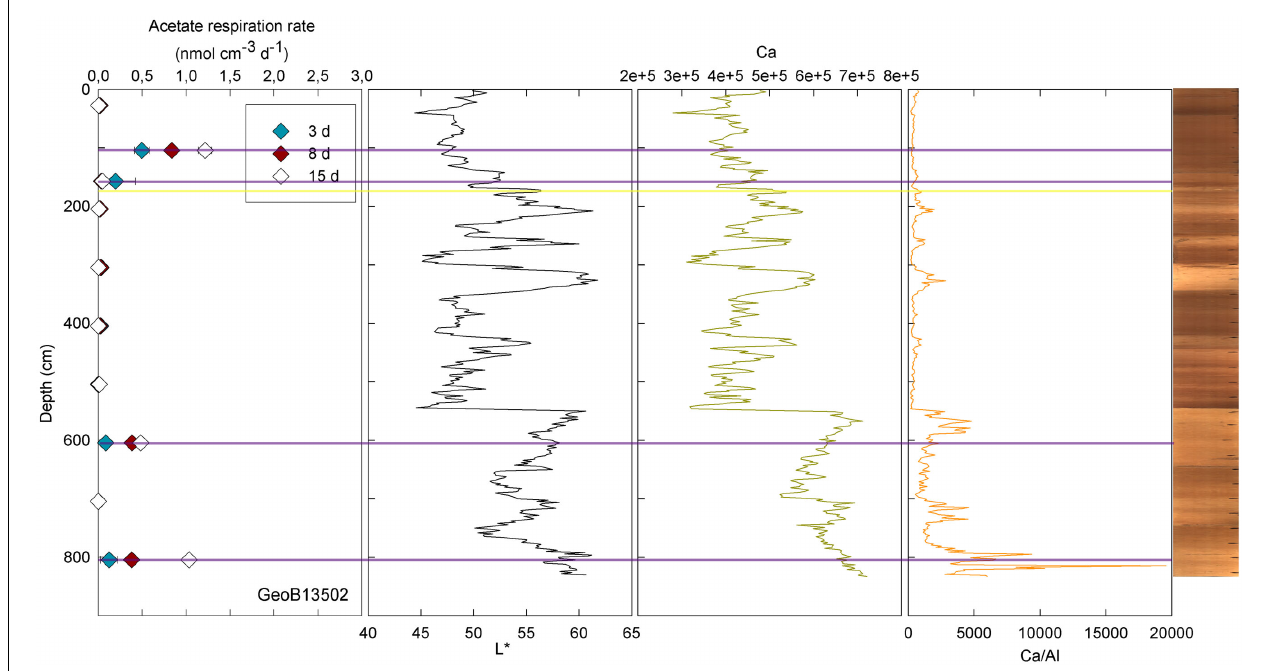
FIGURE 6 | GeoB 13502 linked activities (at 27.5, 104.5, 157, 204.5, 304.5, 404.5, 504.5, 604.5, 704.5, and 804.5cm) and lithological features (L ∗ , Ca, and Ca/Al). Yellow lines denote sandy layers; purple lines denote depths of greater potential acetate turnover.